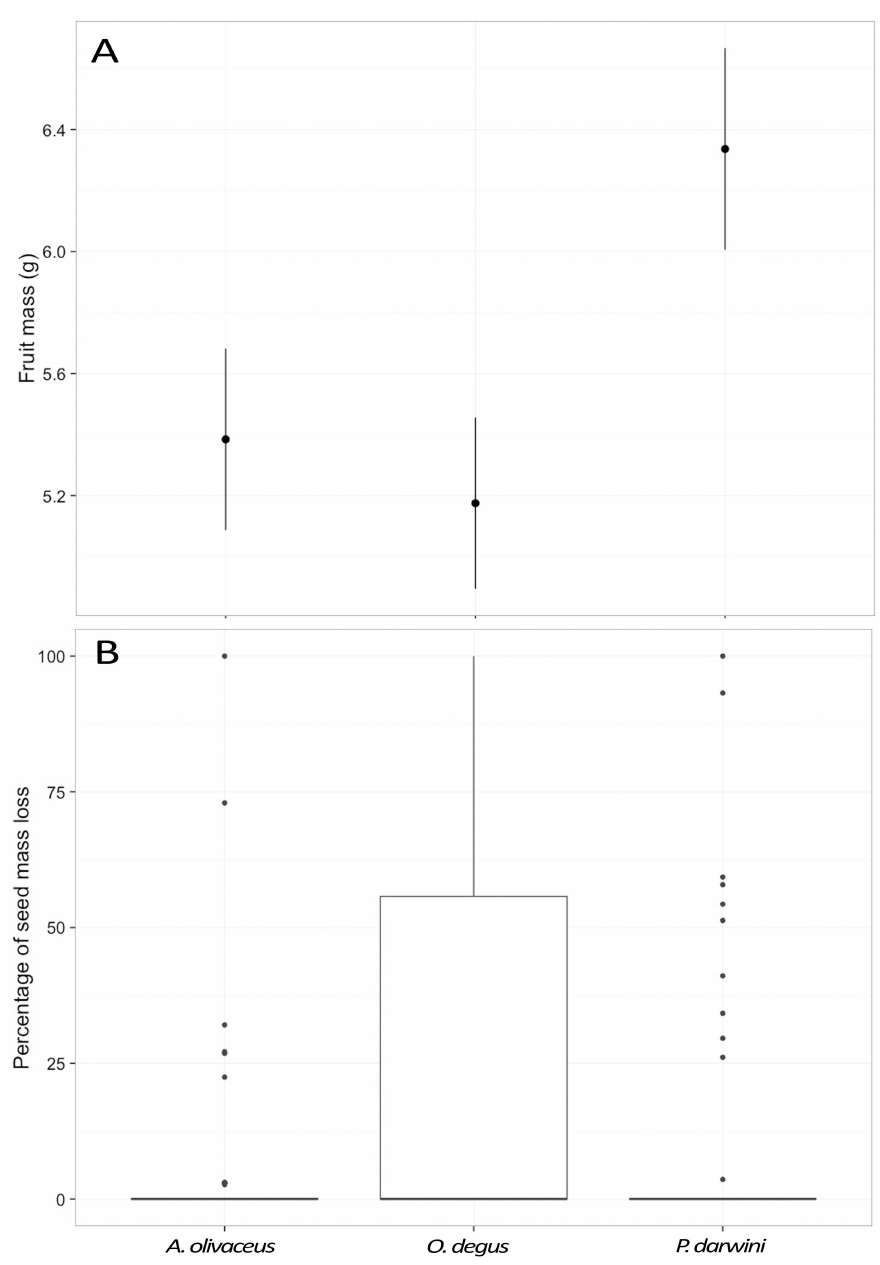
Fig 5. A. Fruit mass of fruits hoardedby A . olivaceus , P . darwini and O . degus .The graph shows means ± 1SE estimated using a mixed effects model. B. Boxplot of the percentageof seed mass consumed in predatedseeds by A . olivaceus , P . darwiniand O . degus .